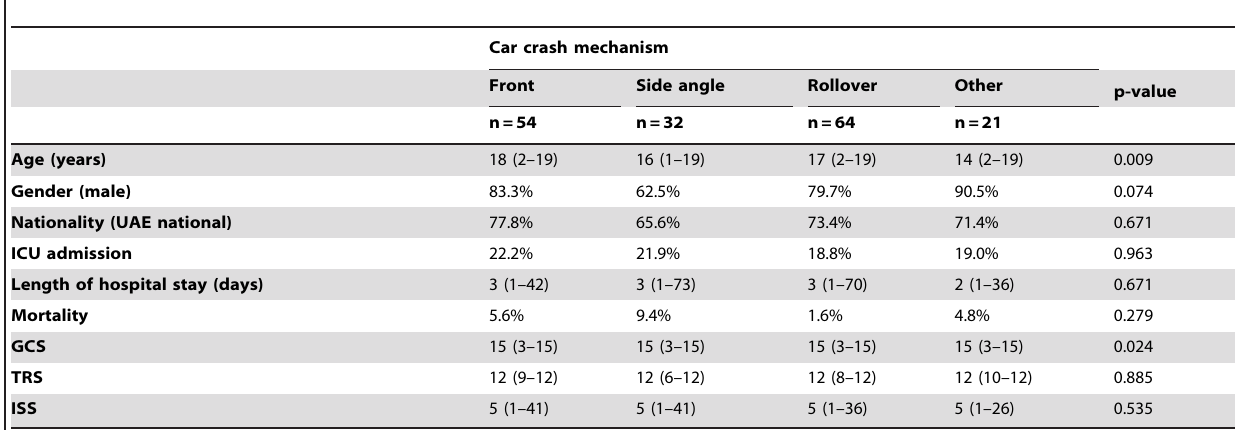
Table 3. Demographic and severity variables by car crash mechanism, Al Ain, 2006–2007